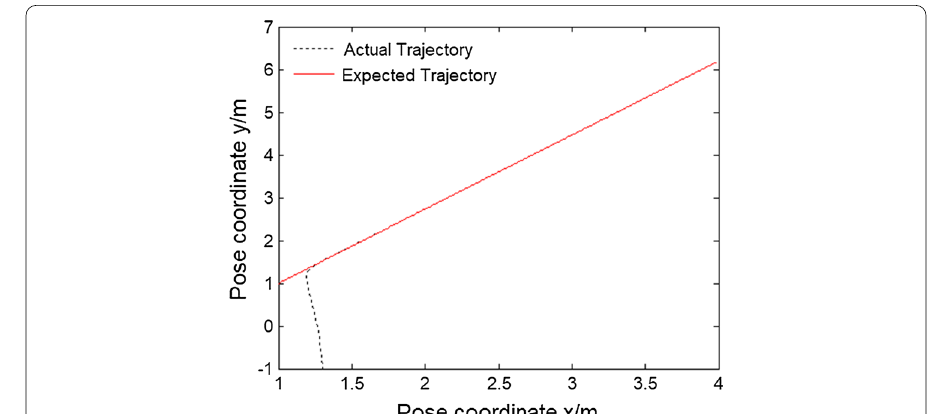
Fig. 3 Effect diagram of linear tracking trajectory